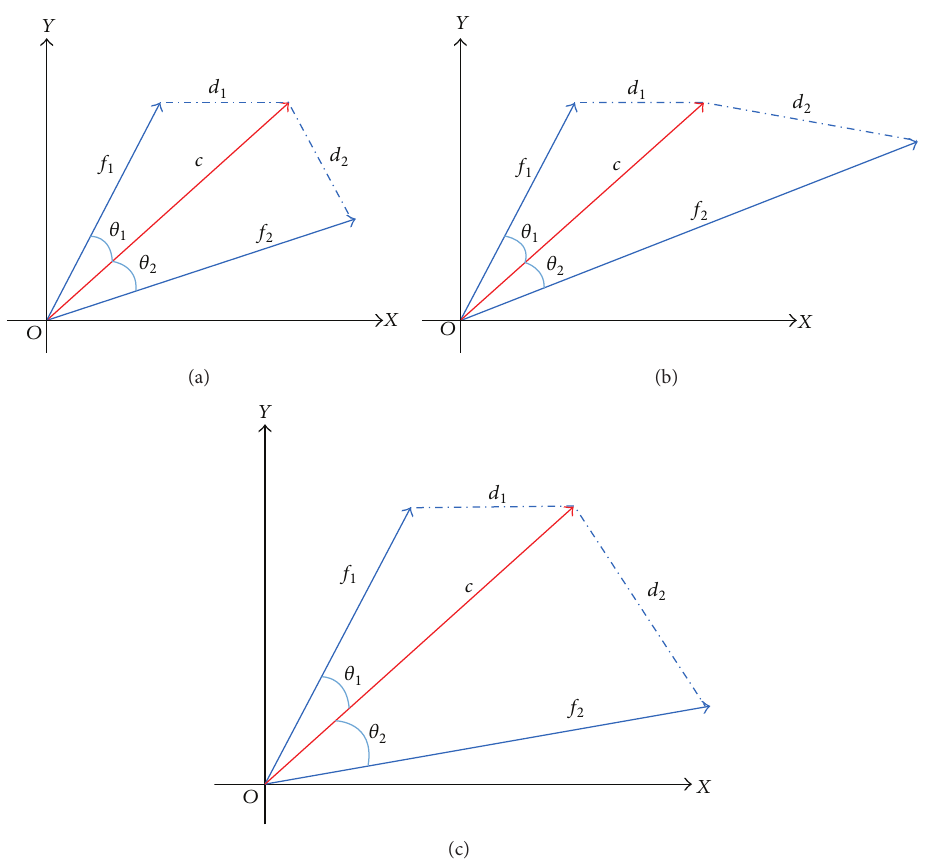
Figure 2: (a) Geometric representation of scenario 1: 𝑑 1 = 𝑑 2 but 𝜃 1 ̸=𝜃 2 . (b) Geometric representation of scenario 2: 𝑑 1 ̸=𝑑 2 but 𝜃 1 = 𝜃 2